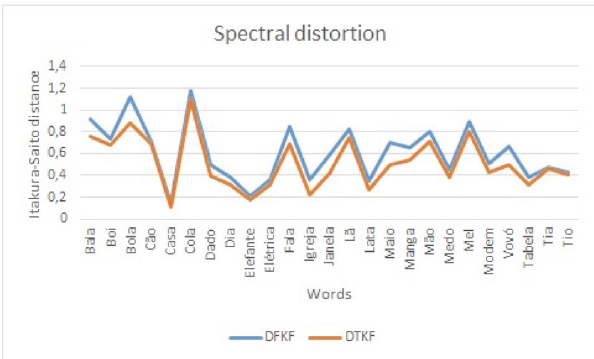
Figure 8: Comparison for spectral distortion for 25 words contami- nated by white noise with signal-to-noise ratio input (SNRI) of 3 dB, using spectral subtraction with prefiltering of the contaminated